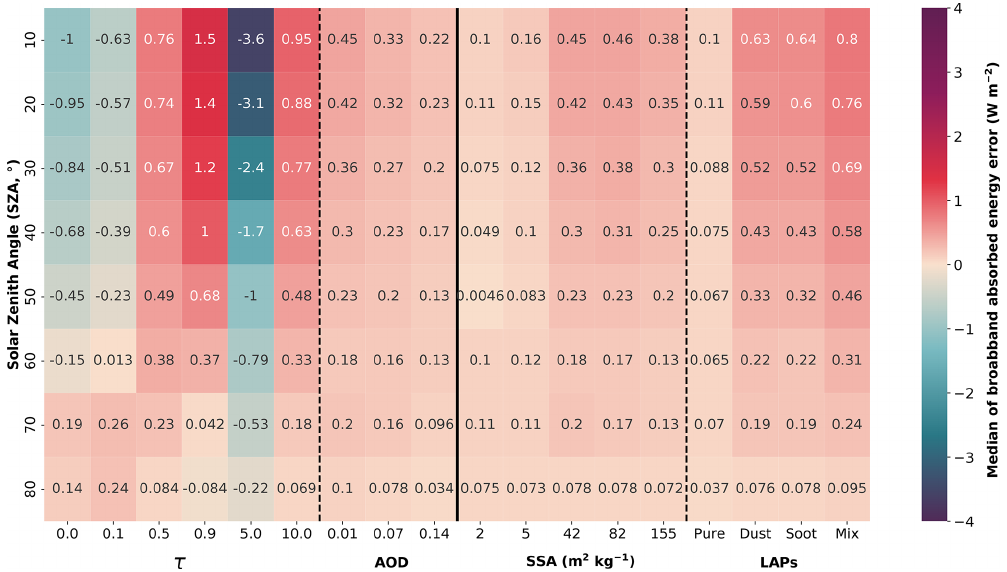
Figure 2. Median error of the broadband absorbed energy for varying SZA, the τ , the AOD, the SSA m 2 kg − 1 , and LAP type. The median error on the broadband absorbed energy is calculated with the ensemble of all the simulations described in Sect. 2.2.3 using 30 TPs with TARTES–SBDART at 1nm resolution as a reference.